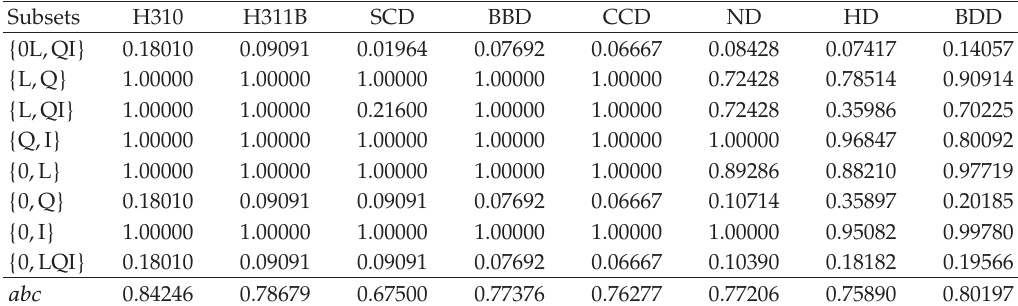
Table 3: Vector Alienation Coe ffi cients γ (cid:5) (cid:2) β abc (cid:3) (cid:7) γ (cid:5) 0 : LQI (cid:6) γ (cid:5) L : QI (cid:6) γ (cid:5) Q : I (cid:6)(cid:8) 1 / 10 , for each of eight small second-order